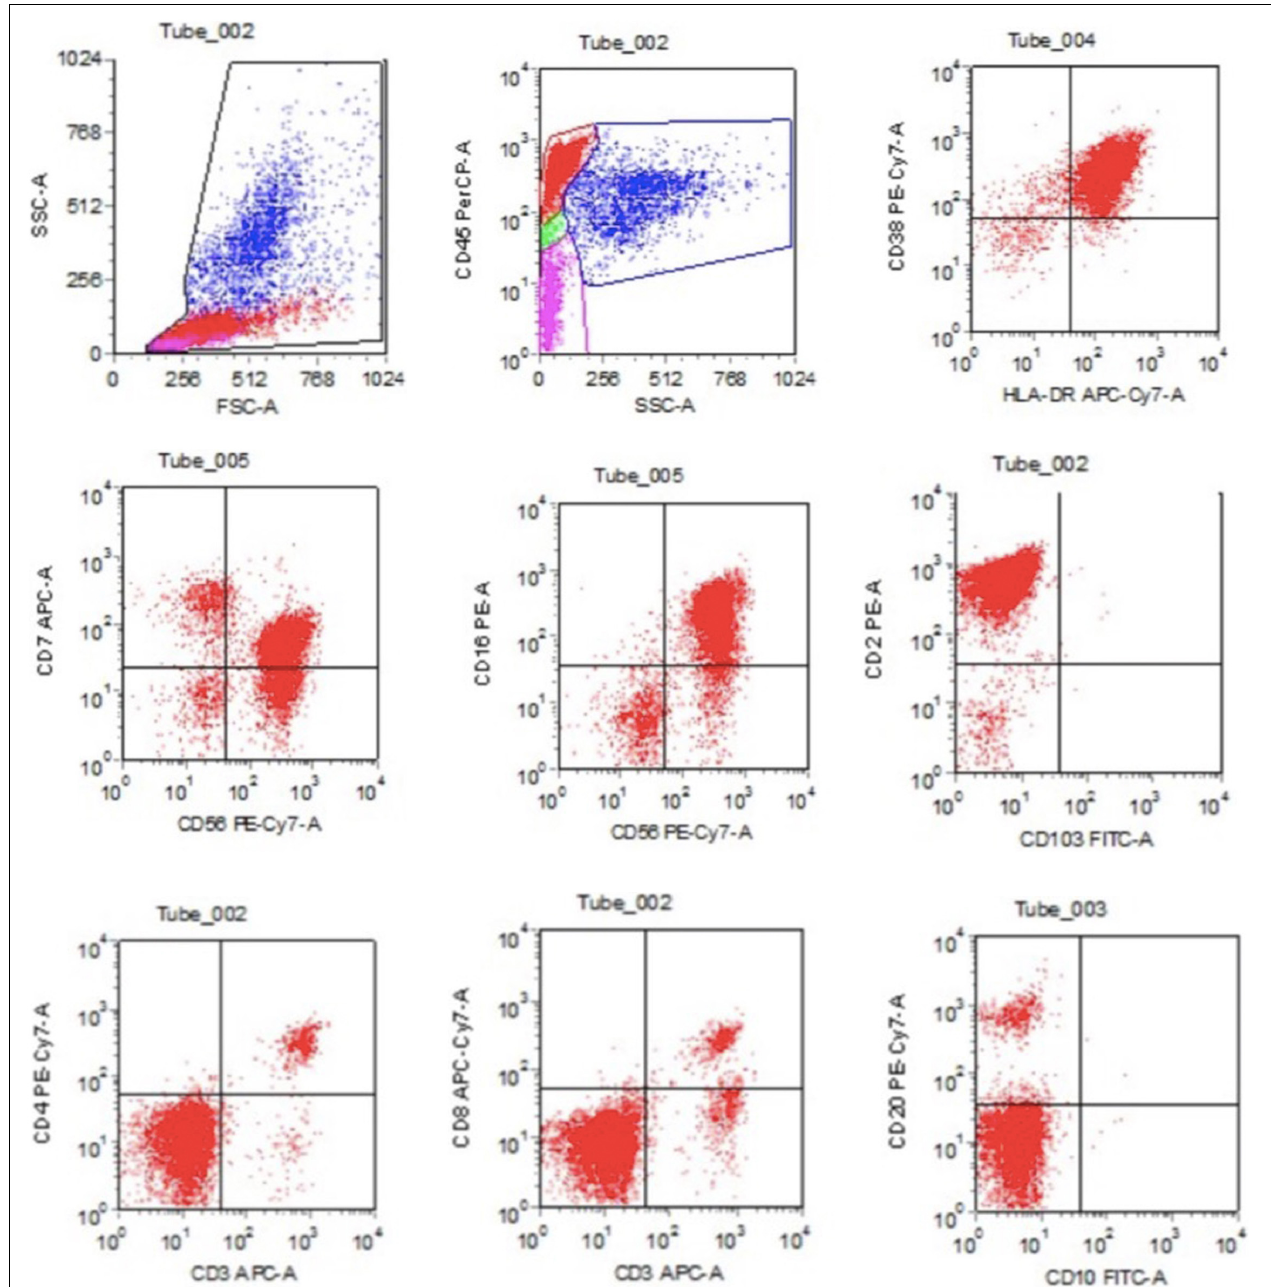
FIGURE 2 | The flow cytometry detection of bone marrow revealed CD3–CD56+ cells counted for 55.67% of the lymphocytes, with HLA-DR+, CD2+, CD7 (dim)+, CD16+, CD38+, CD56+, and